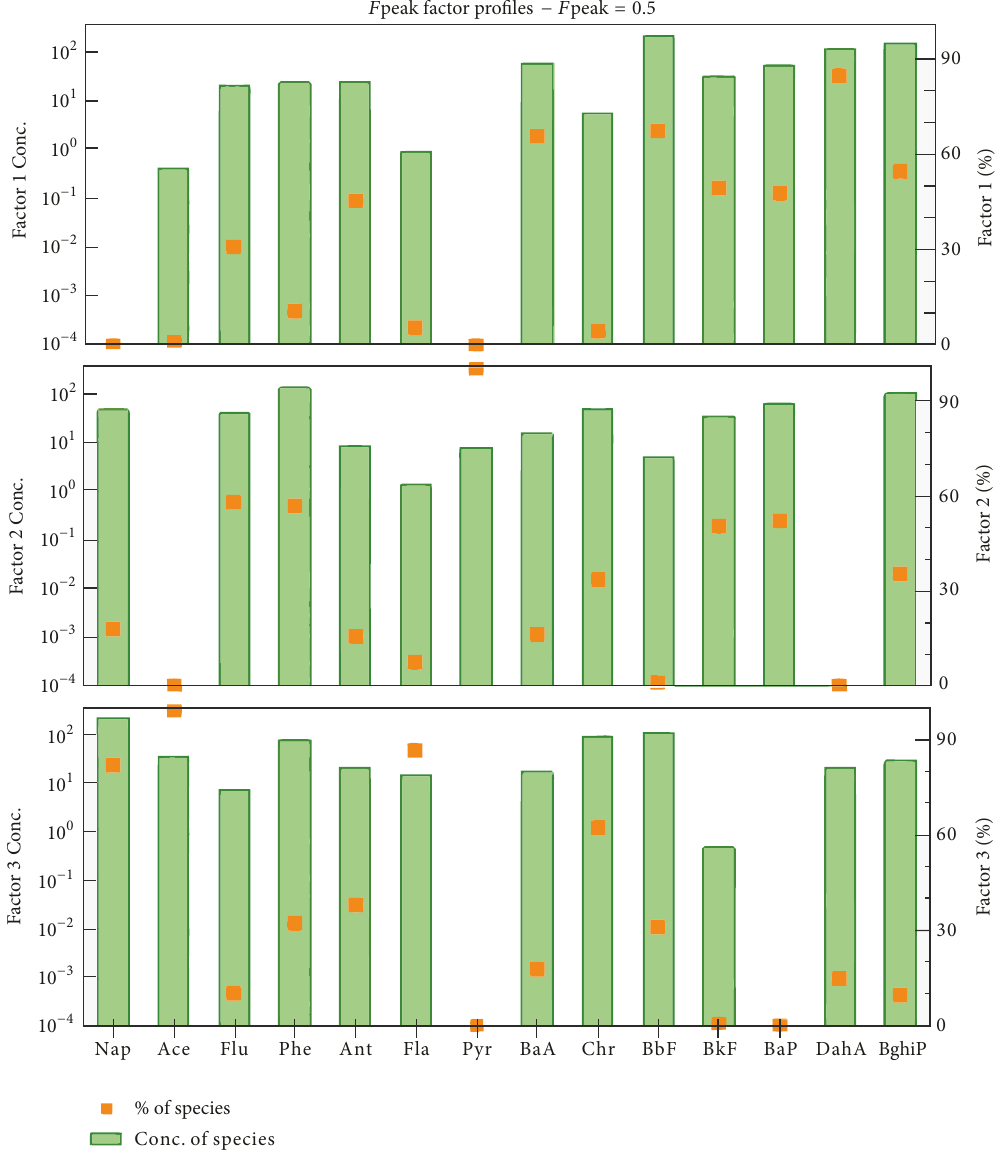
Figure 6: Concentrations and percentage of individual PAHs in each of the three PMF